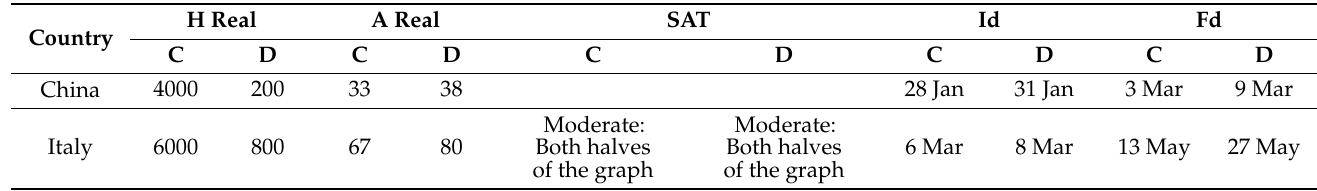
Table 3. Results of the parameters. Part 1.